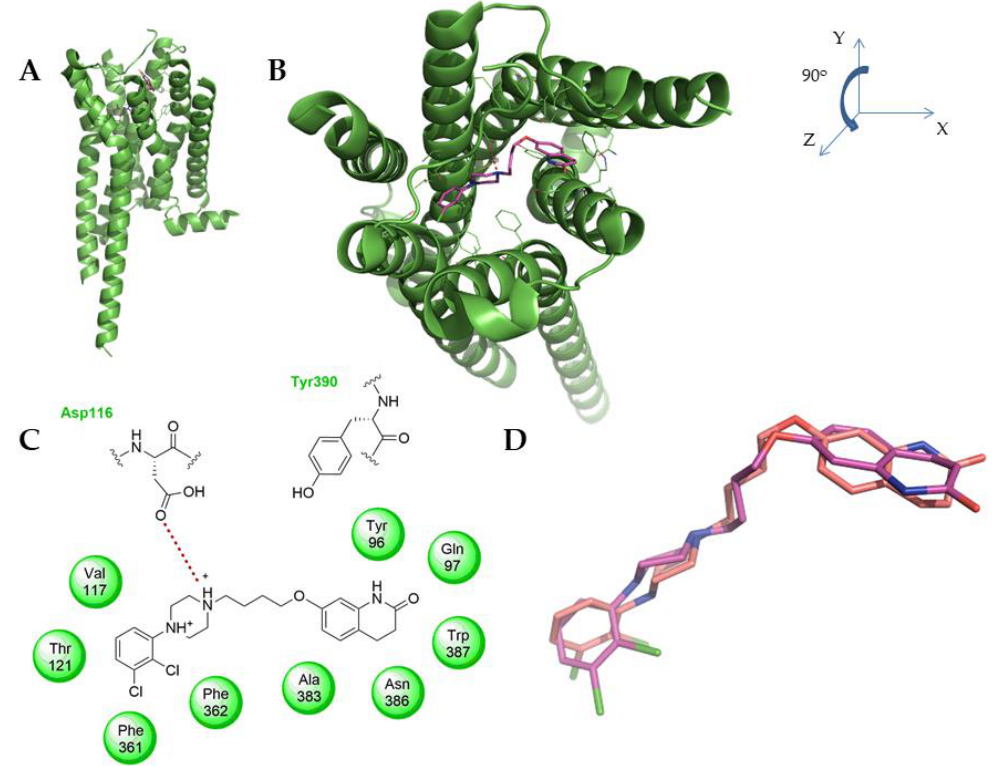
Figure 4. ( A ) Green cartoon representation of the 5-HT 1A receptor with the presence of ( 10 ) at lowest scoring function binding mode as obtained from the software OpenEye in blue colored sticks, ( B ) 2D representation of ( 10 ) binding network forming as obtained from OpenEye software. Brick red dashed lines represent HB between receptor and ( 10 ).